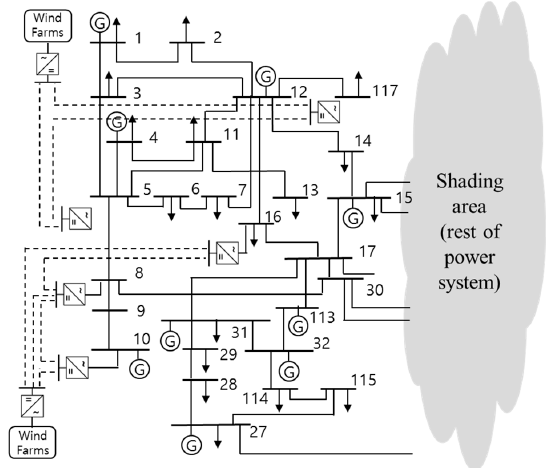
Figure 7. Modified IEEE-118 bus system.